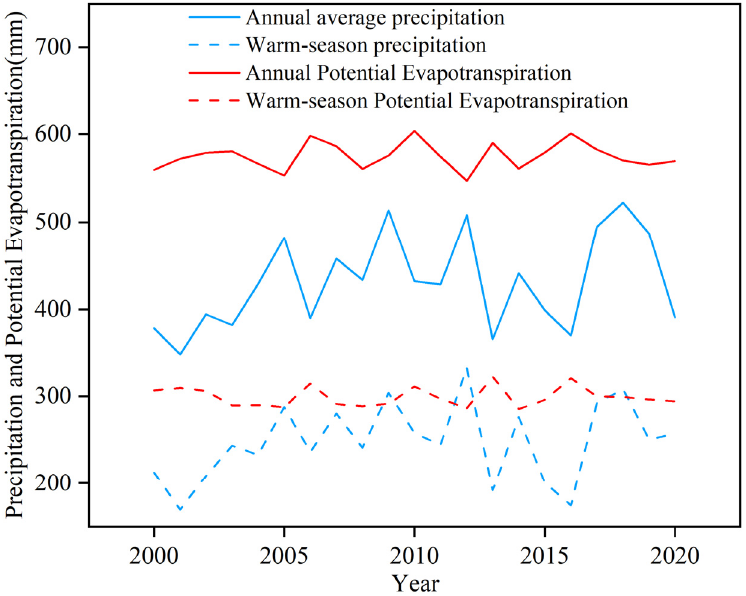
Figure 9. Variations of potential evapotranspiration in the YRSNP from 2000 to 2020.